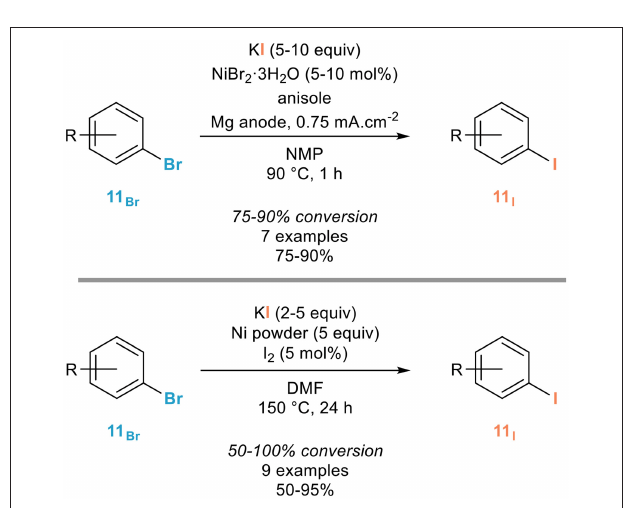
FIGURE 4 | Use of metallic or electro-generated nickel(0) in the aromatic Finkelstein